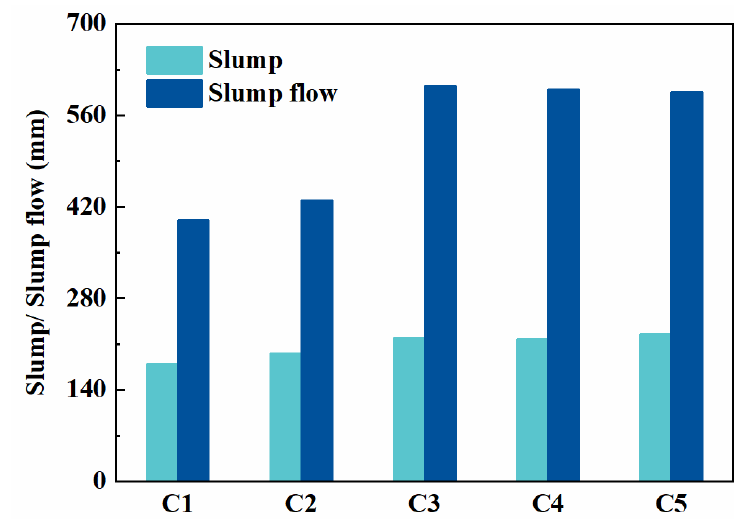
Figure 2. Slump/slump flow of SCC mixtures.